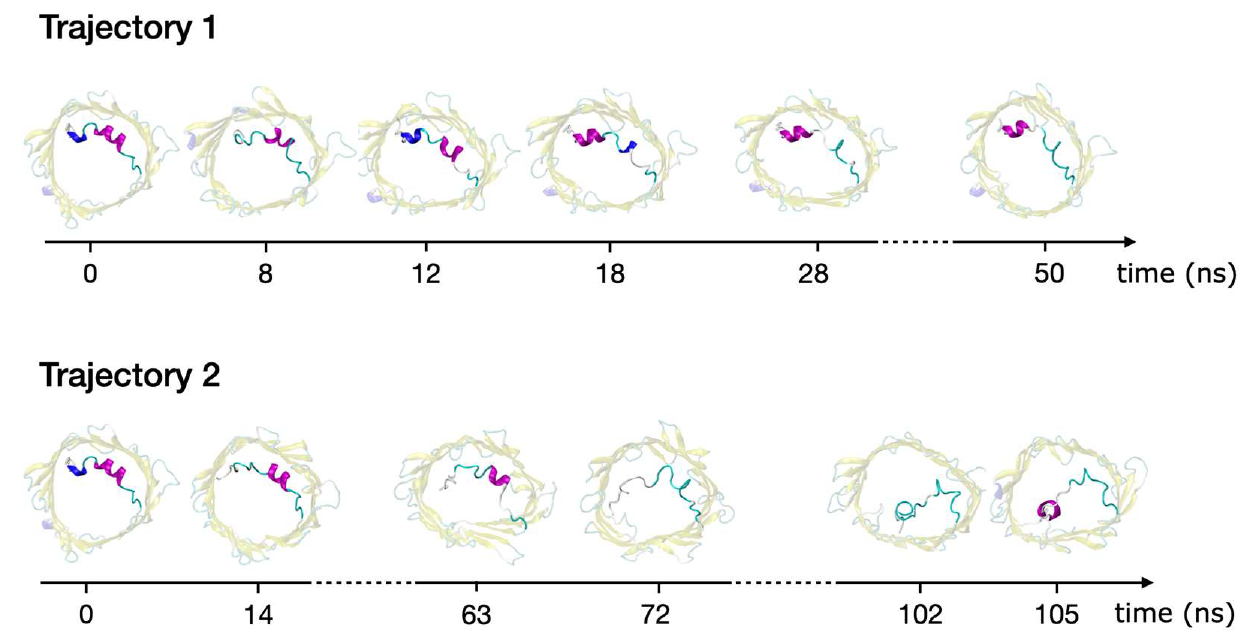
Figure 6. aMD trajectories showing unfolding and refolding of mVDAC1 N-terminal tail. Structures generated all along each trajectory are depicted in top view. The first structure of each trajectory corresponds to a fold similar to the 3EMN crystal structure, while final structures correspond to the refolded N-terminus.